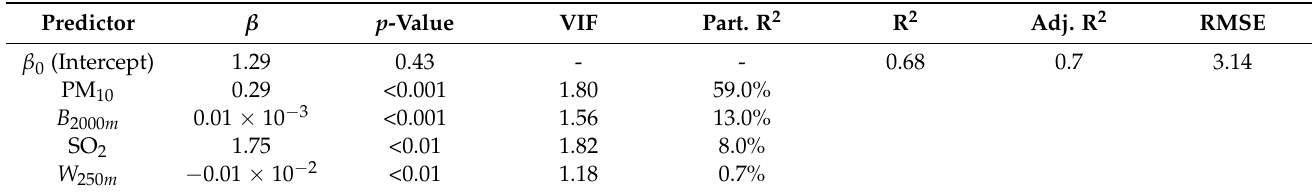
Table 5. Predictor coefficients in Model A for PM 2.5 concentration estimation.